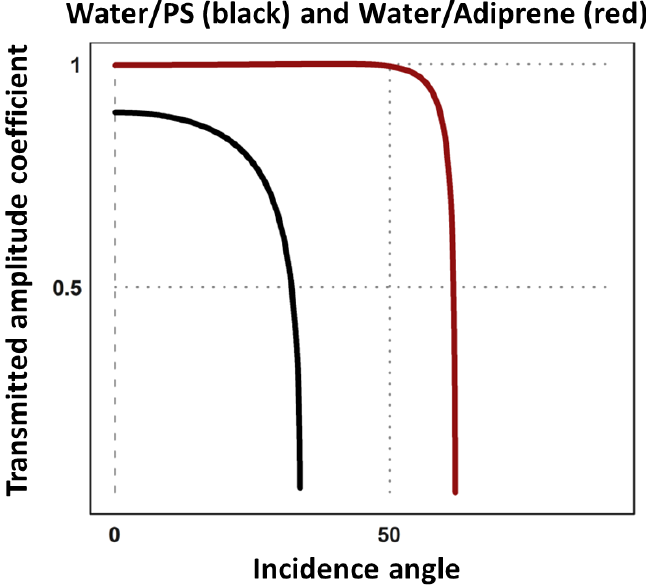
Figure 3. Transmitted amplitude coefficient for oblique incidence depending on the angle to the normal. The black line represents the transmitted amplitude coefficient for a water/polystyrene interface. The red line represents the transmitted amplitude coefficient for a water/adiprene interface for which both a critical angle and an intromission angle exist. The transmitted amplitude coefficient above a critical angle is not defined. For such angles, there is a total reflection of the longitudinal waves. Considering the described setup, the transducer’s intromission angle was fixed at 26.5°.